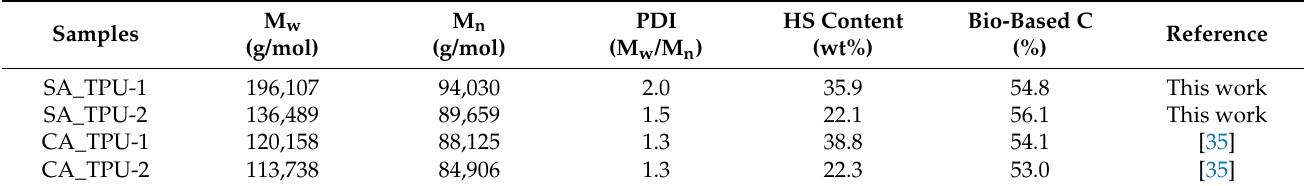
Table 1. Molecular weight, polydispersity, HS content, and bio-content of TPU samples.